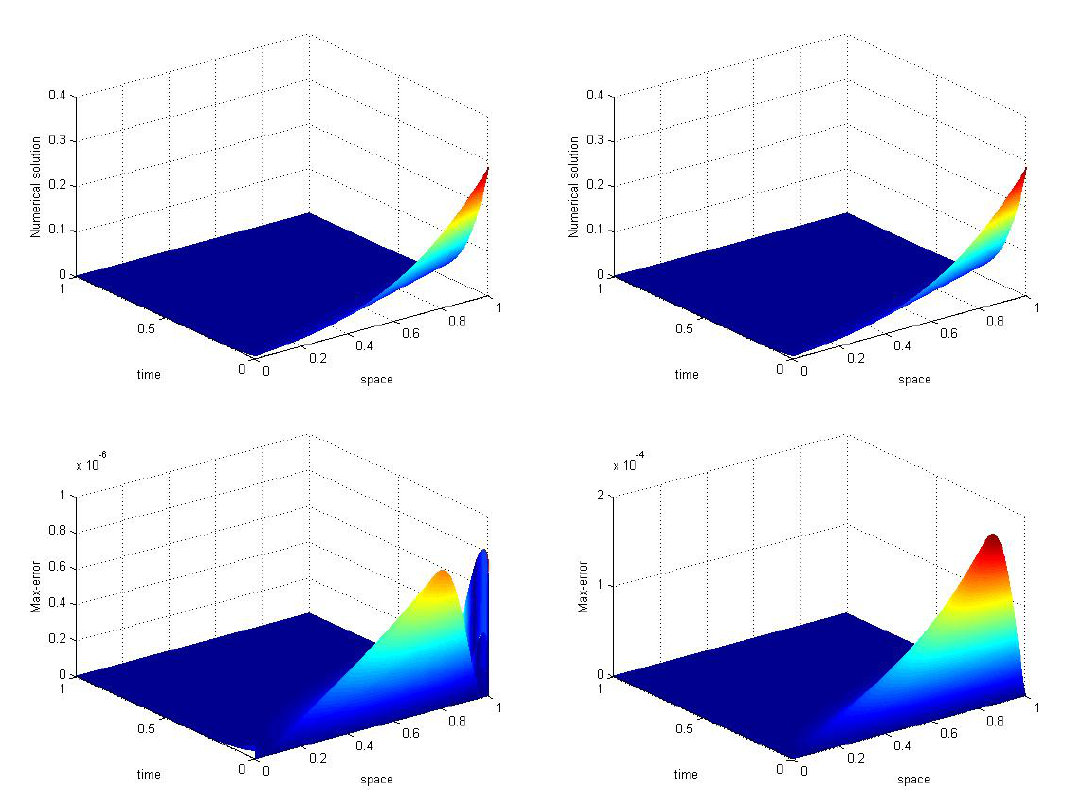
Figure 8. Numerical solution and max-error using modified FVM ( Left ) and central scheme of FVM ( right ) for convection dominance taking v = 3, k = 0.01 ( ∆ t = 1/3000, ∆ x = 1/320 for numerical example